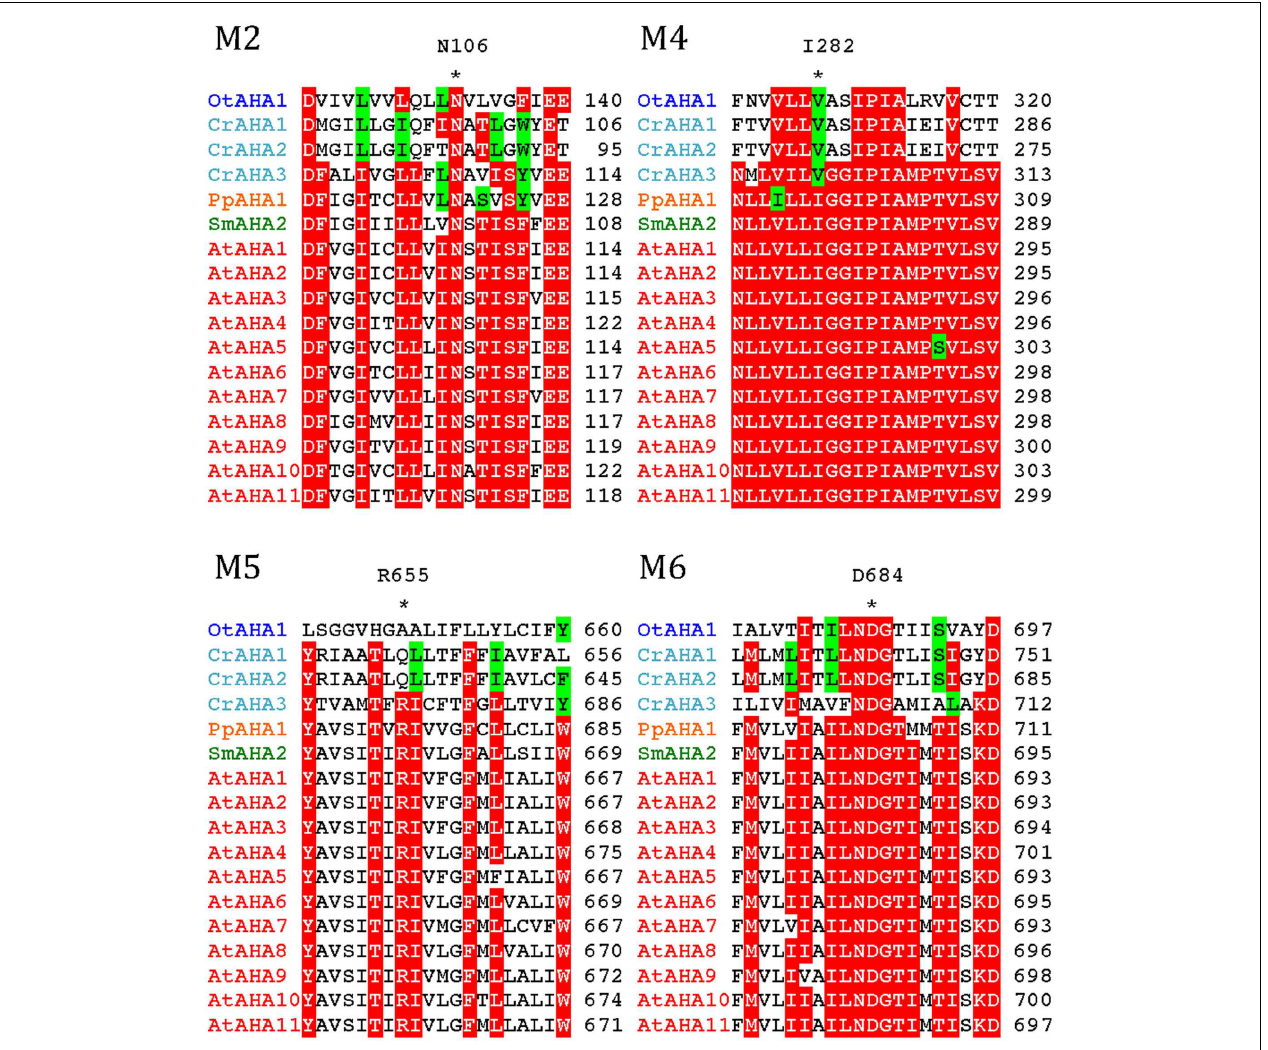
number of the amino acid residue in AtAHA2 is indicated above each asterisk. R655 in M5, which seems important for controlling backflow of H + at high electrochemical gradients (Pedersen et al., 2007), is lacking in some chlorophyte H + -ATPases.